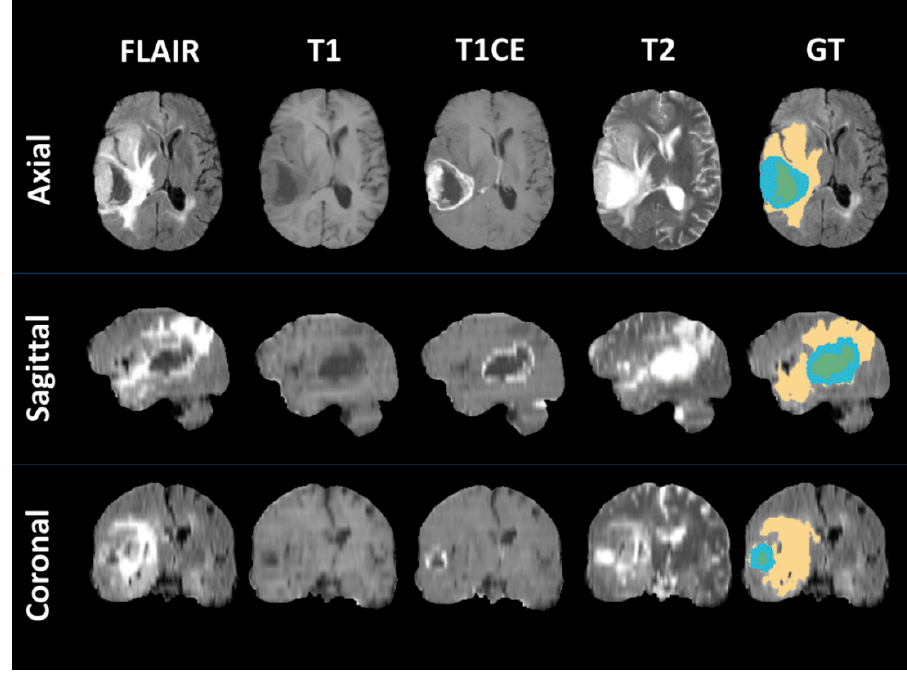
Figure 3. An illustrative example of how to segment the MRI scan of a patient with GBM into three di ff erent regions (non-enhanced part of tumor core (NET): green, enhanced part of tumor core (ET): blue, peritumoral edema (ED): yellow, GT: ground